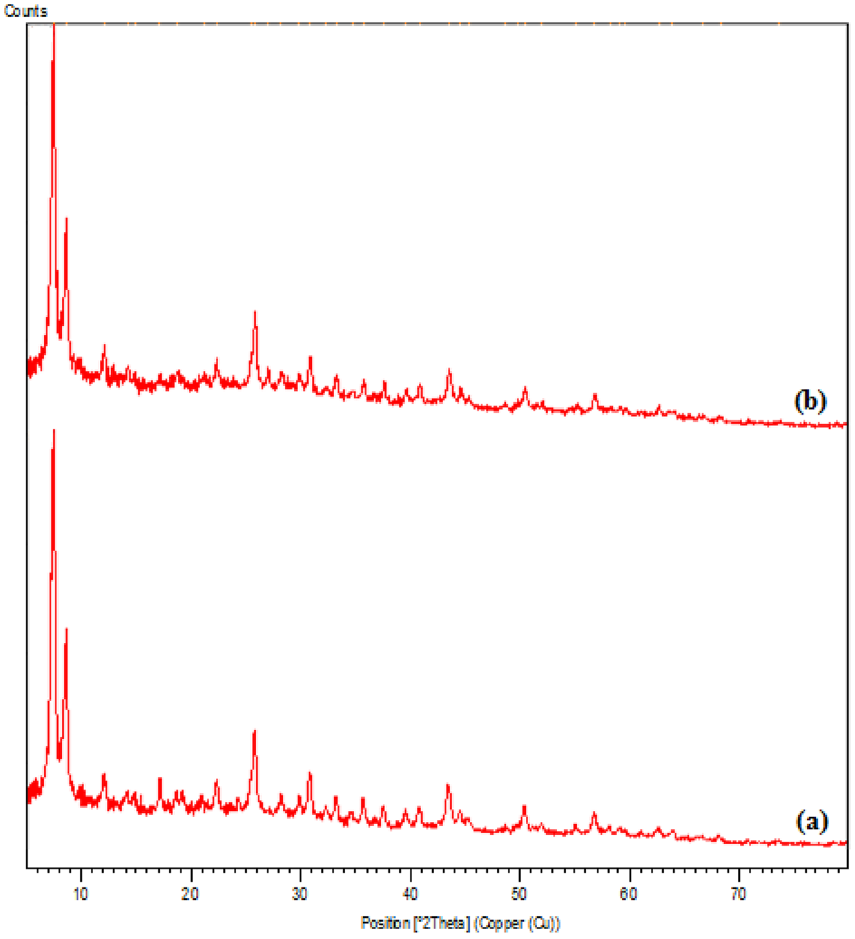
Figure 7. XRD patterns of UiO-66-NH 2 ( a ); and UiO-66-biguanidine/Pd ( b ).